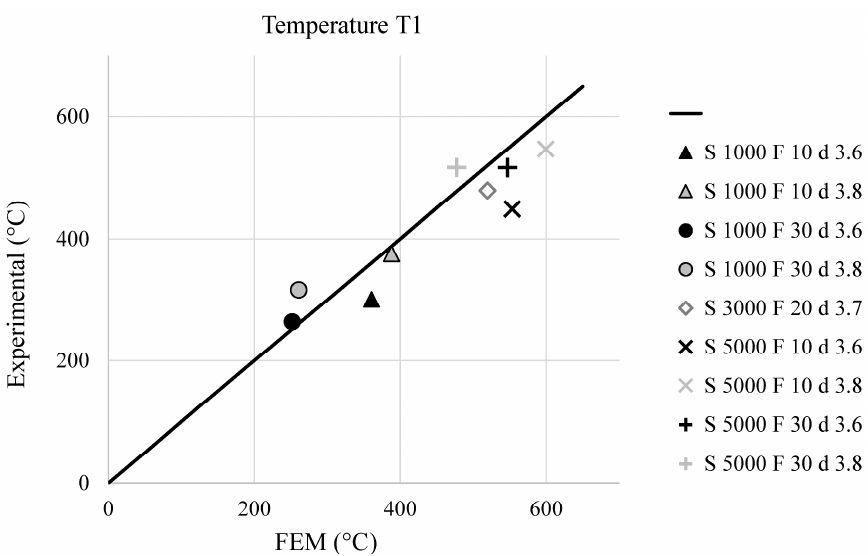
Figure 10. Comparison between experimental and simulated maximum temperatures at 3 mm from the joint axis, for the different welding conditions.